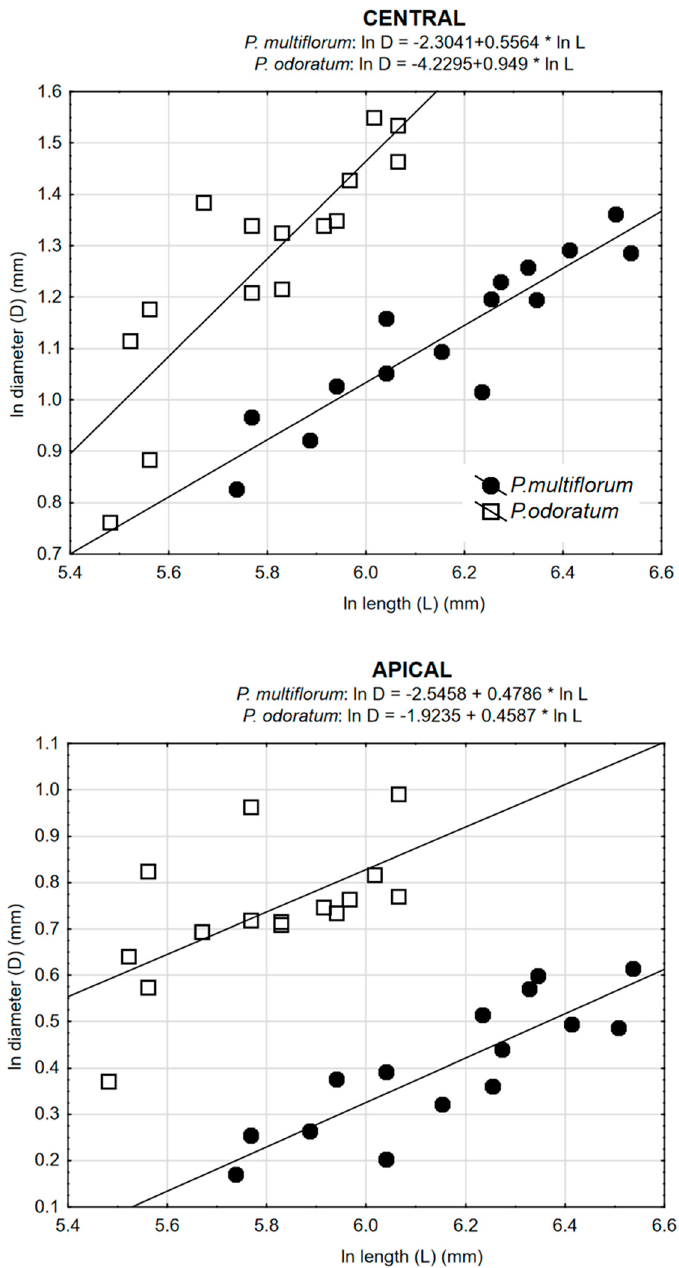
Figure 5. Relationships between diameter and length for all three regions of the shoot for the two species P. odoratum and P. multiflorum.